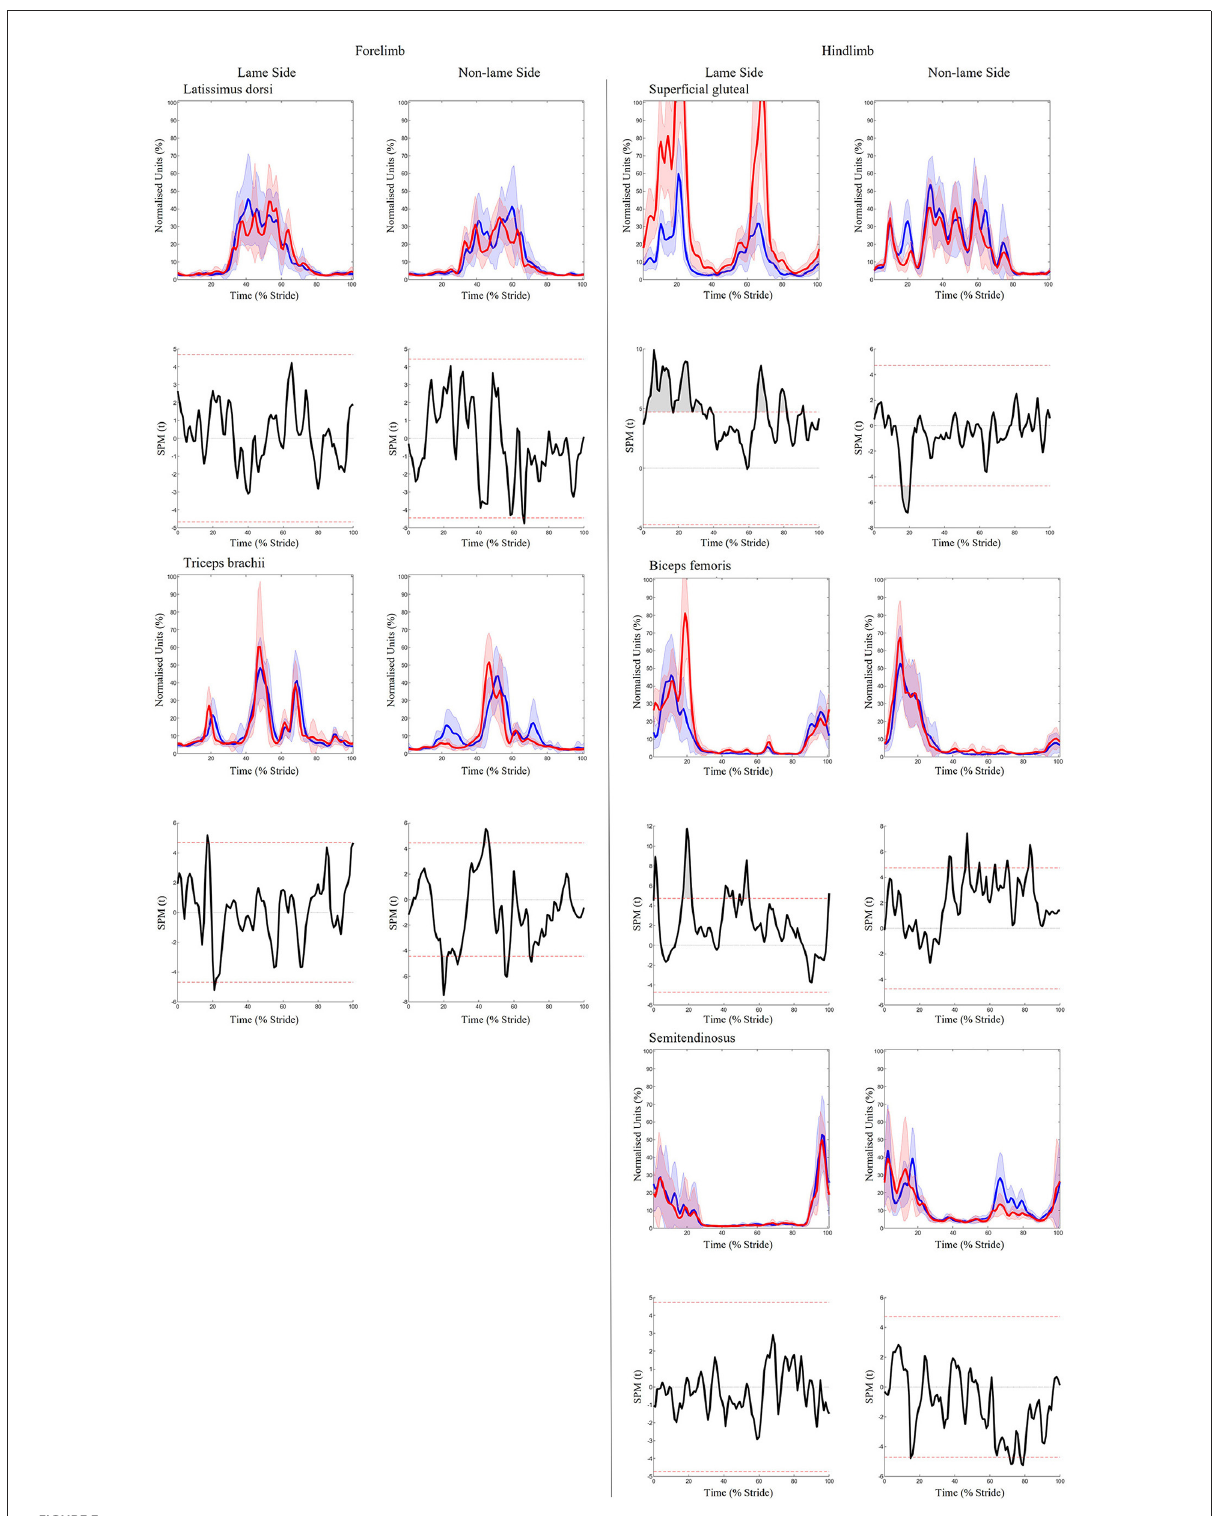
FIGURE3 SPM results for time- and amplitude-normalized sEMG data from a representative “horse 1” ( n = 1) for studied superficial muscles of the forelimb (Left panel) and hindlimb (Right panel) during baseline 1 (blue solid lines/shaded area) and induced forelimb lameness (red